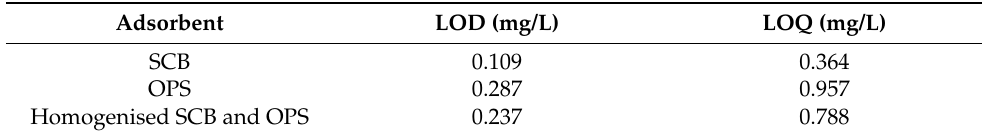
Table 6. LOD and LOQ for Pb(II)